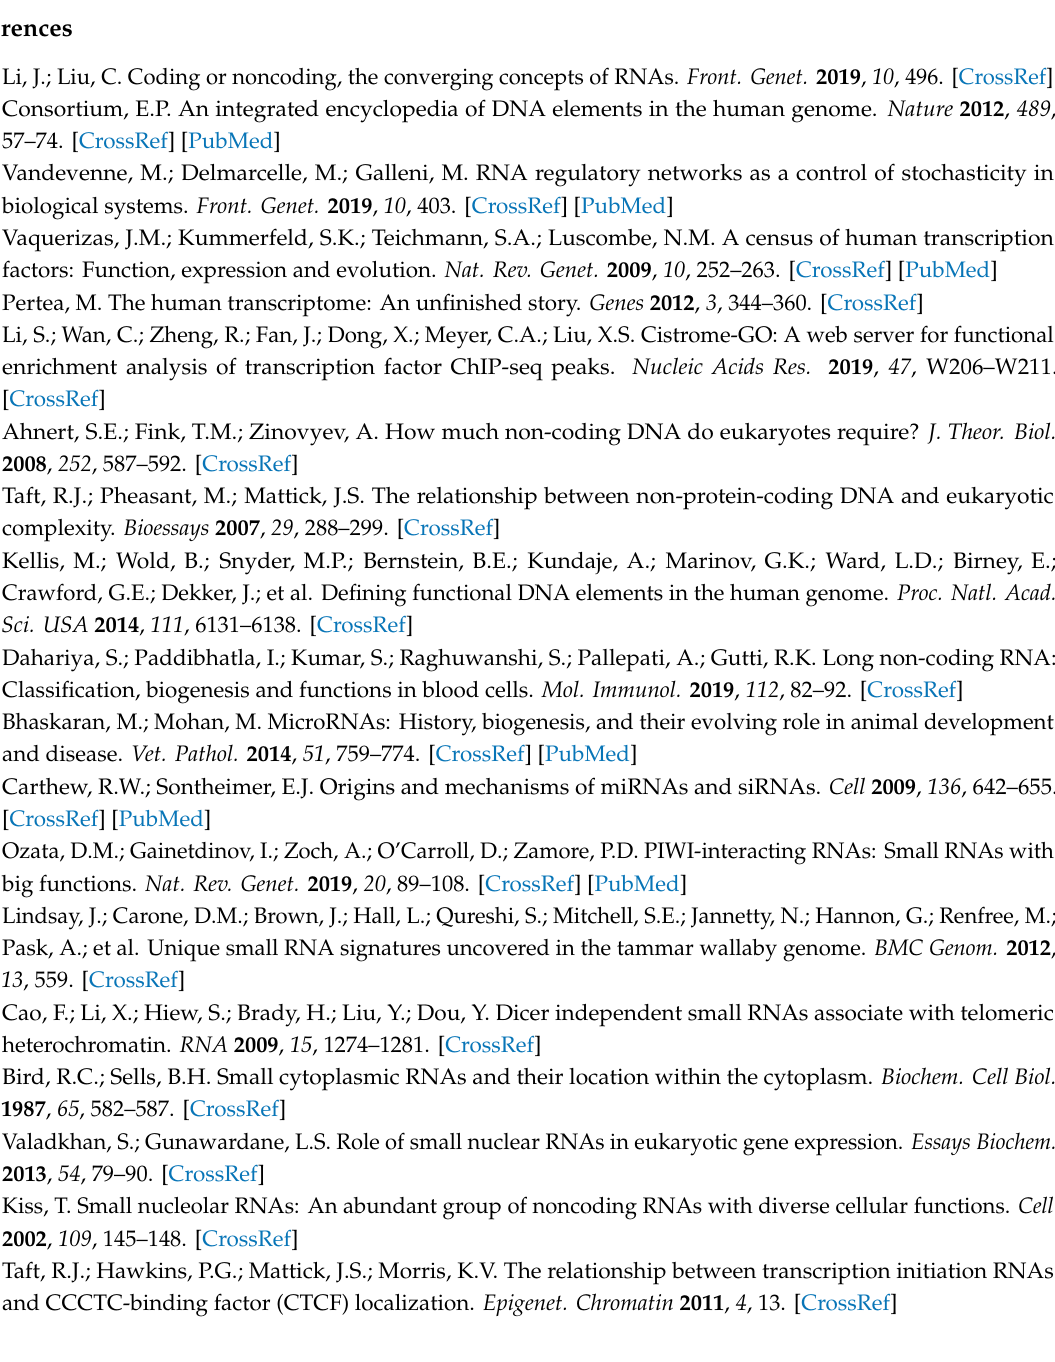
Table S1: Small peptides coded by lncRNAs and their function. Table S2: List of lncRNAs with a validated function. Table S3. Interactions between lncRNAs and other